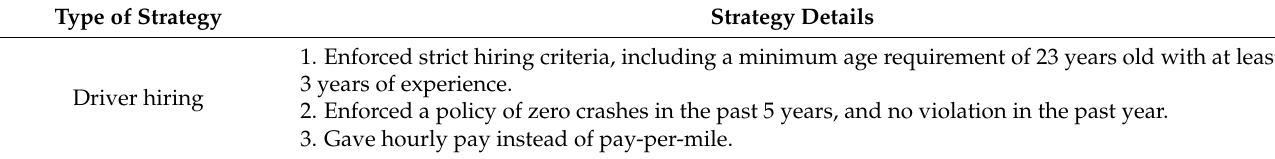
Table 8. Fleet F safety improvement